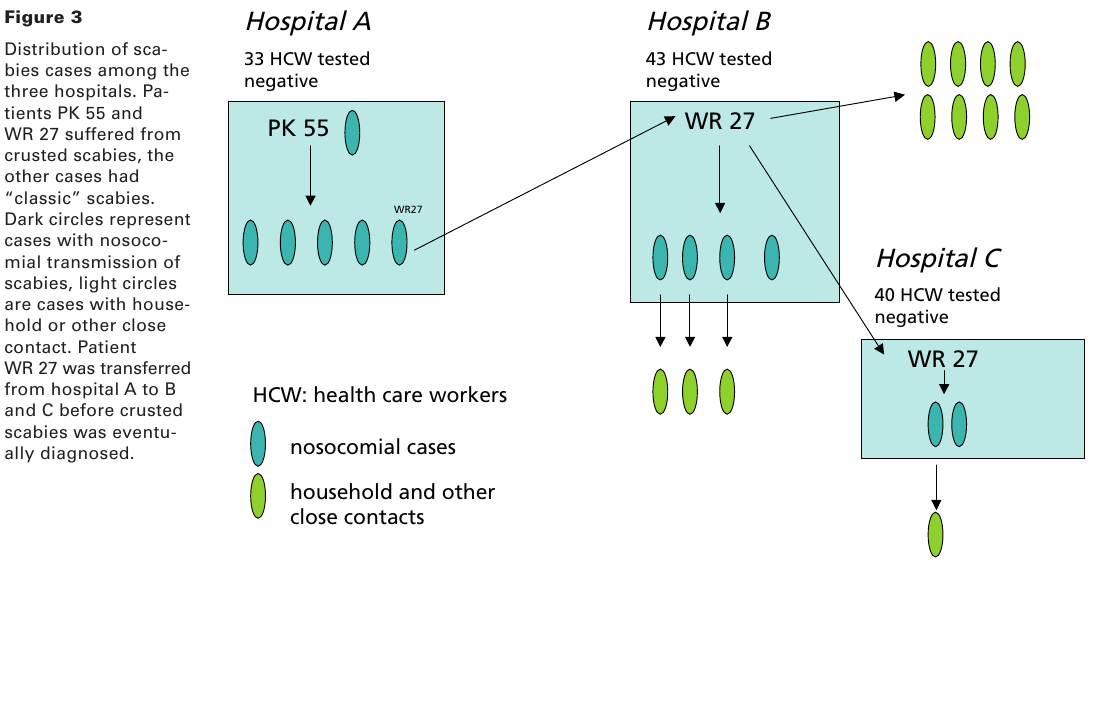
Figure 3 Distribution of sca- bies cases among the three hospitals. Pa- tients PK 55 and WR 27 suffered from crusted scabies, the other cases had “classic” scabies. Dark circles represent cases with nosoco- mial transmission of scabies, light circles are cases with house- hold or other close contact. Patient WR 27 was transferred from hospital A to B and C before crusted scabies was eventu- ally